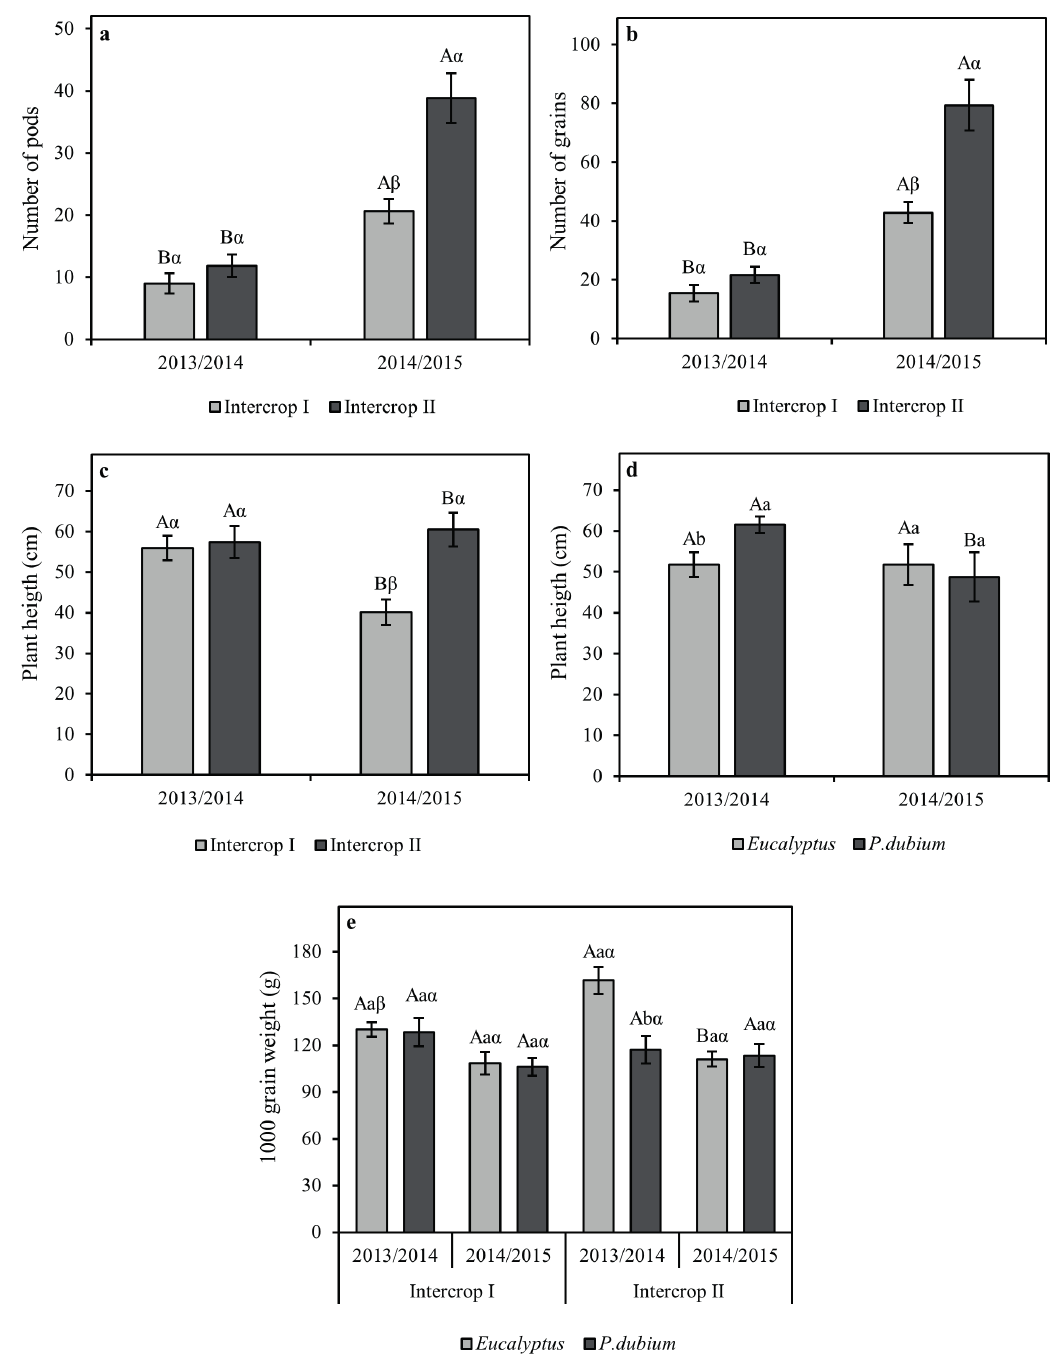
Figure 4 - Yield components of soybean cultivated in agroforestry systems during two crop years (2013/2014 and 2014/2015). Number of pods per plant ( a ), number of grains per plant ( b ), plant height ( c and d ) and 1000-grain weight ( e ). Southern, Brazil. Means followed by the same letters, uppercase comparing the crop years, lowercase the forest species Eucalyptus and P. dubium , and greek letters comparing the Intercrop systems, have not significant difference by the Tukey test (p<0.05). Each bars represent average values ±